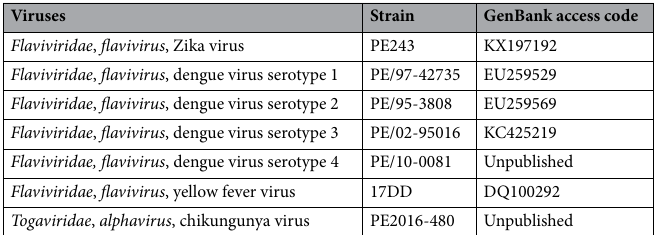
Table 1. Viruses used to evaluate the analytical specificity of the ZIKV RT-LAMP assay.